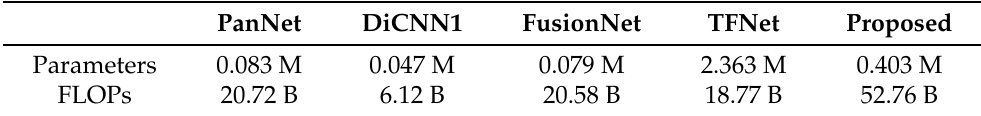
Table 12. Performance comparison of CNN-based methods in terms of number of parameters and number of